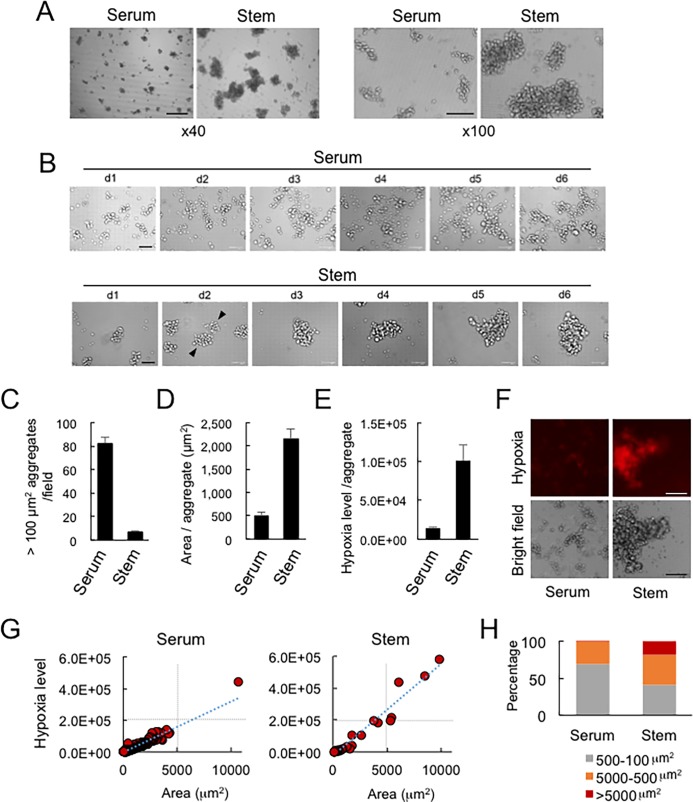
Quantification of size and hypoxia level of GLAs in serum-stimulated and stemness-induction conditions.(A) The grape-like aggregation (GLA) of PC-3 cells in the serum-contained or stem-cell medium. Scale bar, 100 μm. (B) Time-lapse imaging of maturation of GLA of PC-3 cells. Fusion of small GLAs was seen to form larger GLAs in the stem cell induction condition. Arrowheads indicate pre-fusion aggregates. Scale bar, 100 μm. (C) Numbers of cellular aggregations per field. A cellular aggregation sized more than 100 μm2 diameters was defined as a GLA. A well of a 96-well plate was sectionized to 9 fields, and the area of 1 field is 2,632 μm2. n = 4. Biological replicates. (D) The average area of GLAs. n = 3. Biological replicates. (E) Hypoxia levels of the aggregations. n = 3. Biological replicates. (F) Hypoxia imaging by using a hypoxia probe. Scale bars, 200 μm. (G) Scatter plot analysis of areas and hypoxic levels of the GLAs. GLAs in random 4 fields were analyzed. Approximate straight lines were shown. Left, n = 1338. Right, n = 27. (H) The difference in sizes of GLAs. Gray, 100 to 500 μm2; orange, 500 to 5000 μm2. Red, > 5000 μm2.